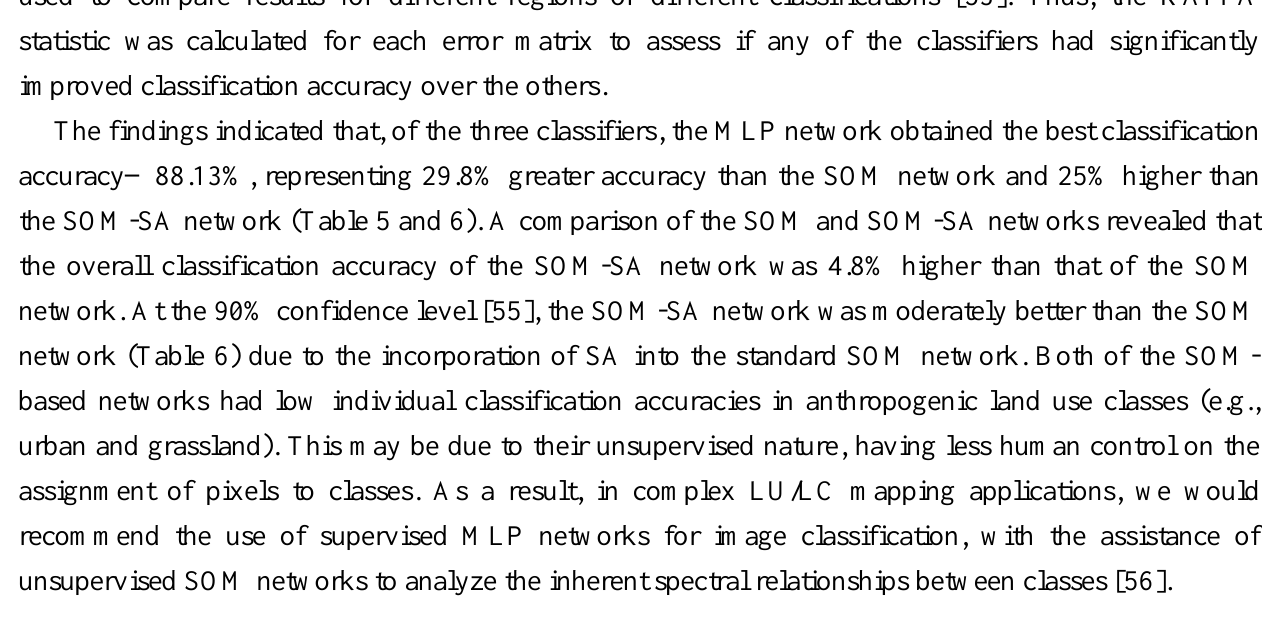
Table 5. Individual Kappa Analysis for the three network error matrices.